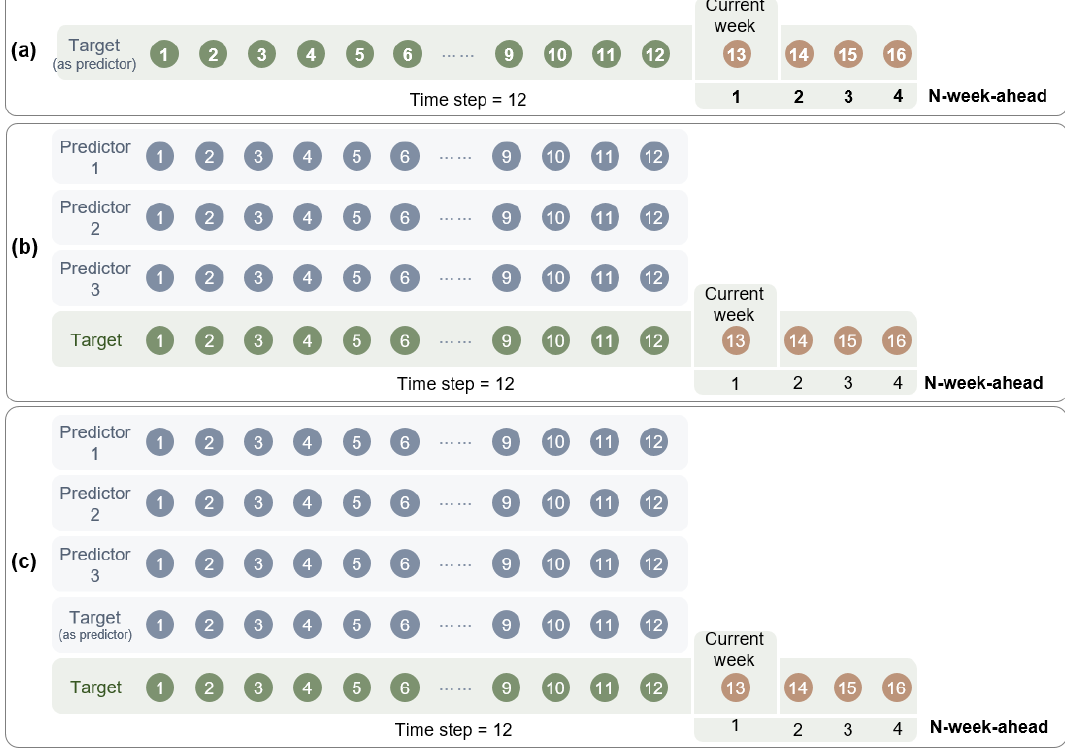
Figure 8. Illustration of N-week-ahead dengue risk forecasting in different LSTM-based prediction scenarios: ( a ) indicates the prediction based on historical dengue data; ( b ) indicates the prediction based on external predictors; and ( c ) indicates the prediction based on both historical dengue data and external predictors.